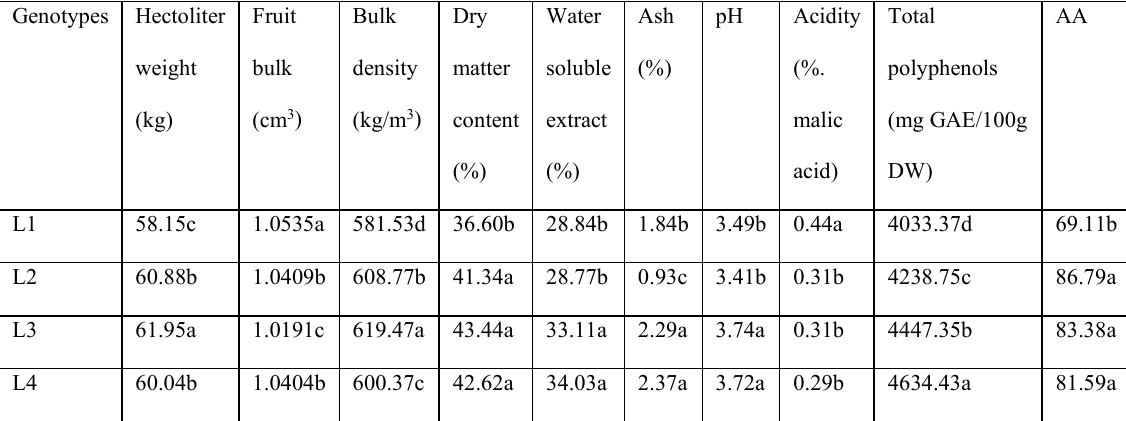
Table 2. Pomological and phytochemical characteristic of genotypes of rosehip fruits